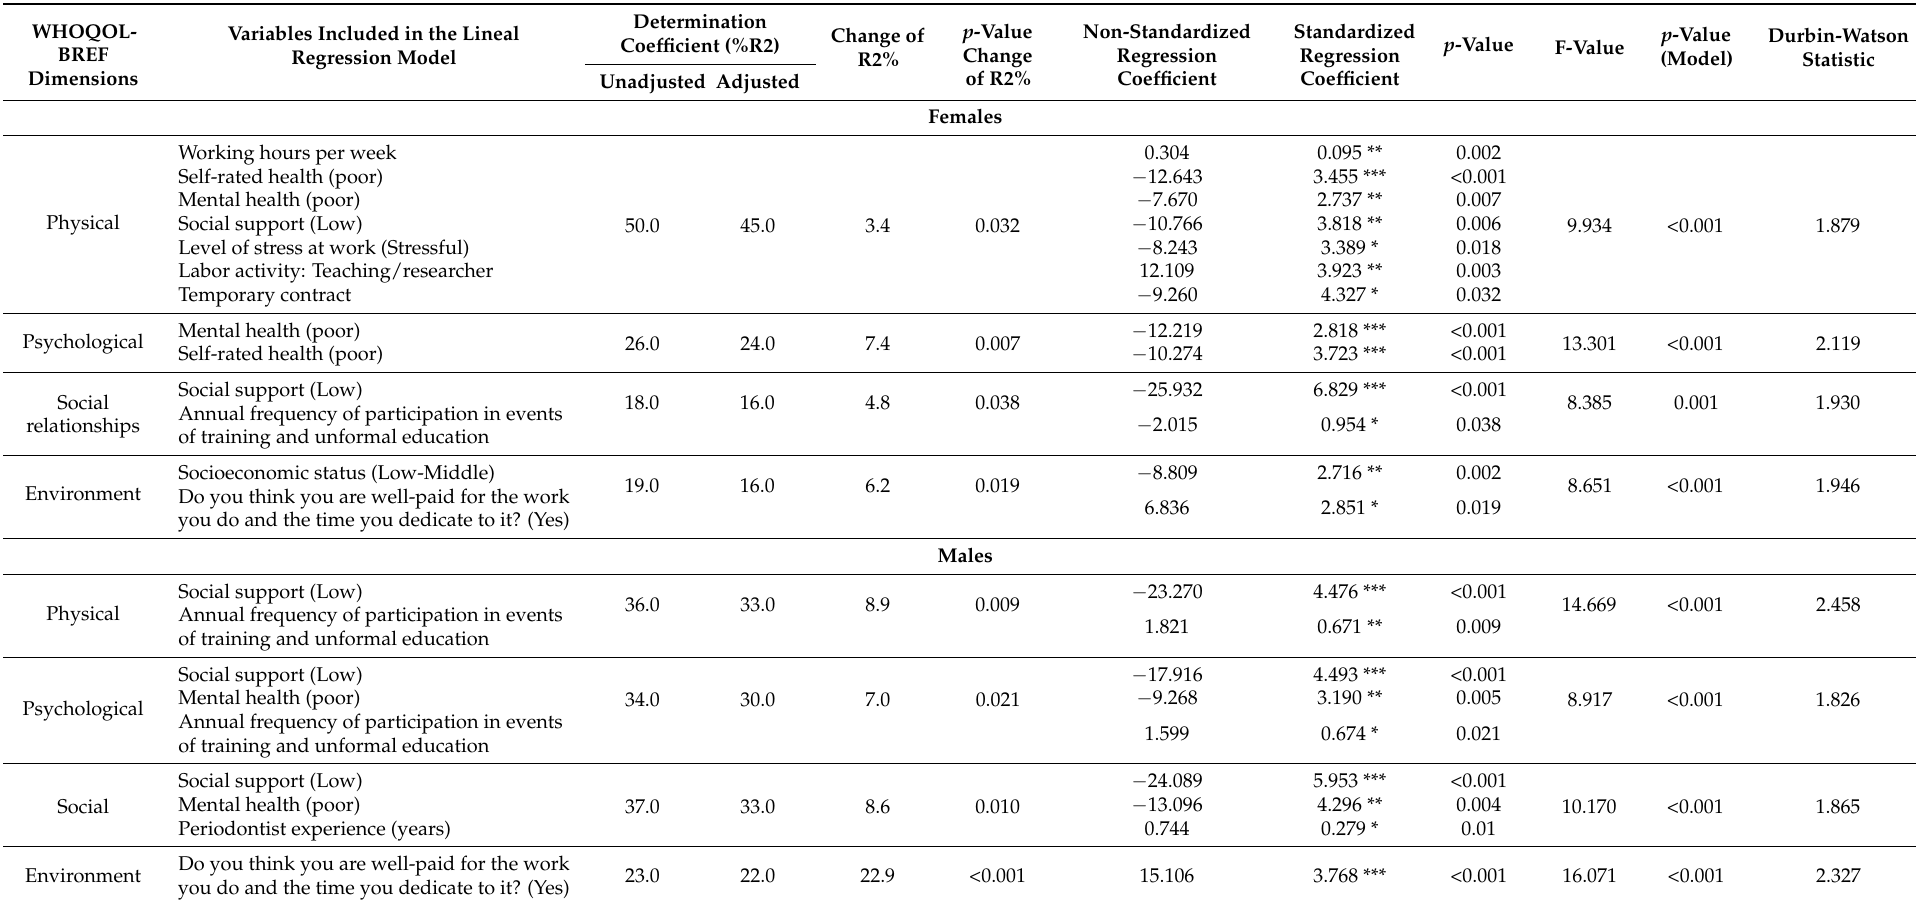
Table 2. Lineal regression models for the scores of the WHOQOL-BREF dimensions of QOL according to the variables included in the study sample. Medell í n, 2021–2022 ( n =